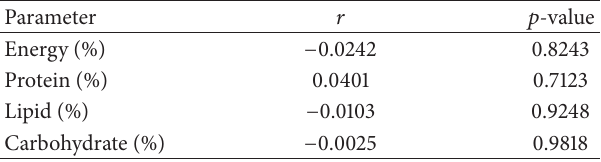
Table 6: Correlation analyses between visceral fat area and intake (%) of energy and each nutrient in patients with MAC lung